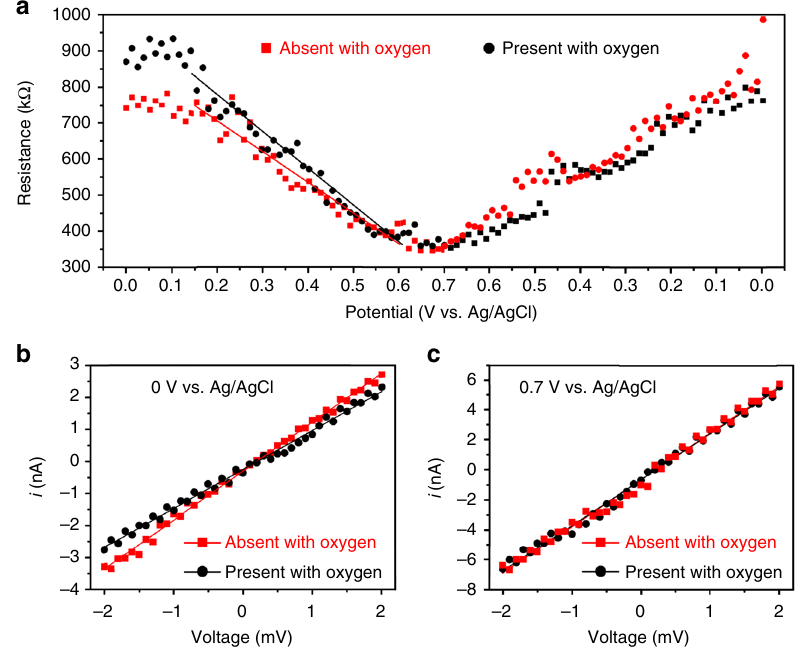
Fig. 3 Temporal electrical transport measurement of the Ni-graphene nanosheet-based device. a Resistance (under potential bias 2 mV) vs. electrochemical potentials trace corresponding to Fig. 2a. b I – V characteristics of a typical Ni-graphene nanosheet-based device at potential of 0 V vs. Ag/AgCl. c I – V characteristics of a typical Ni-graphene nanosheet-based device at potential of 0.7 V vs. Ag/AgCl